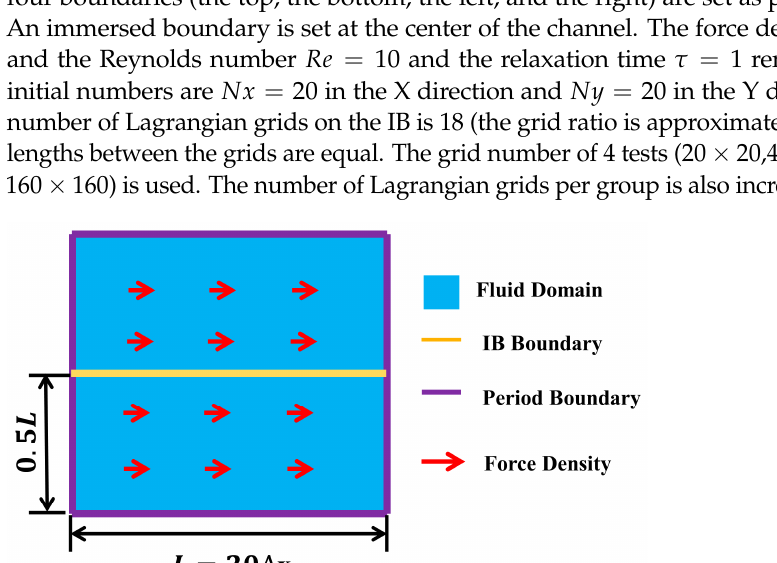
Figure 3. The computational domain of the symmetrical Poiseuille flow with one IB.